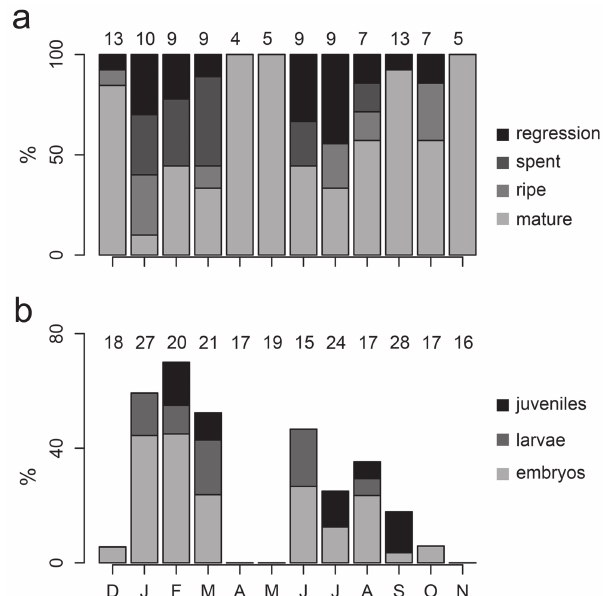
Fig. 3. Monthly variation in (a) the frequency of ovarian development stages and (b) the frequency of mouth- brooding females carrying embryos, larvae, or juveniles.